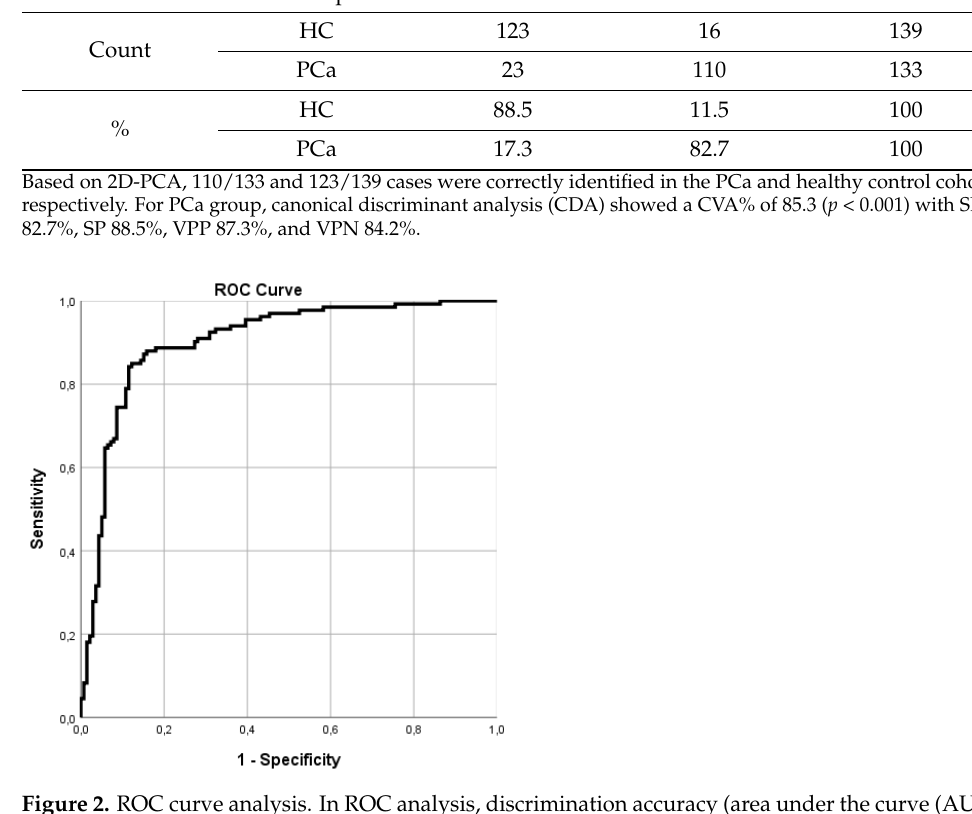
Figure 2. ROC curve analysis. In ROC analysis, discrimination accuracy (area under the curve (AUC)) was 0.9.